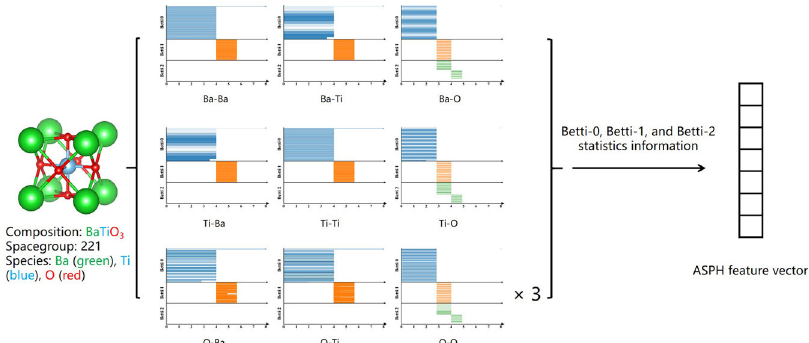
Fig. 6 The construction process of BaTiO 3 topological feature. First, compute all barcodes of the combinations formed by each atom in the unit cell as a central atom and surrounded by various element types. The ASPH features are then generated from the statistics data of these barcodes. Since the unit cell of BaTiO 3 having three O atoms, the barcode data of this type in the fi gure is multiplied by